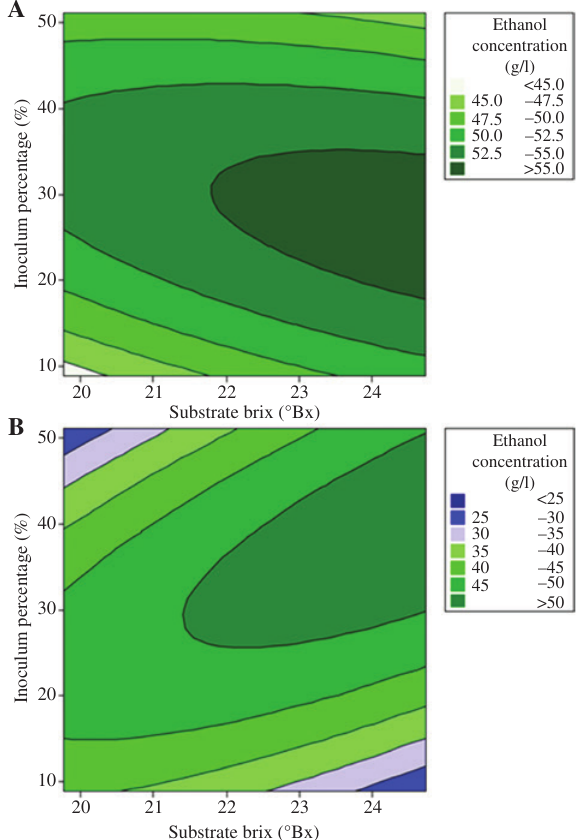
Figure 2: Contour plots for concentration of the produced bioethanol (g/l) as function of the substrate brix ( ° Bx) and inoculum percentage (%), during fermentation using the yeast strains (A) SFO6 and (B) NCYC